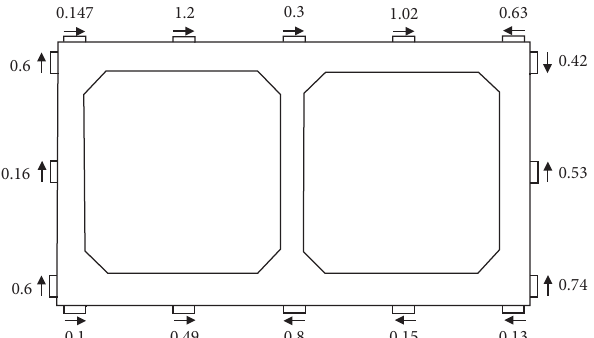
Figure 27: Concrete circumferential shear stress of surface (unit: